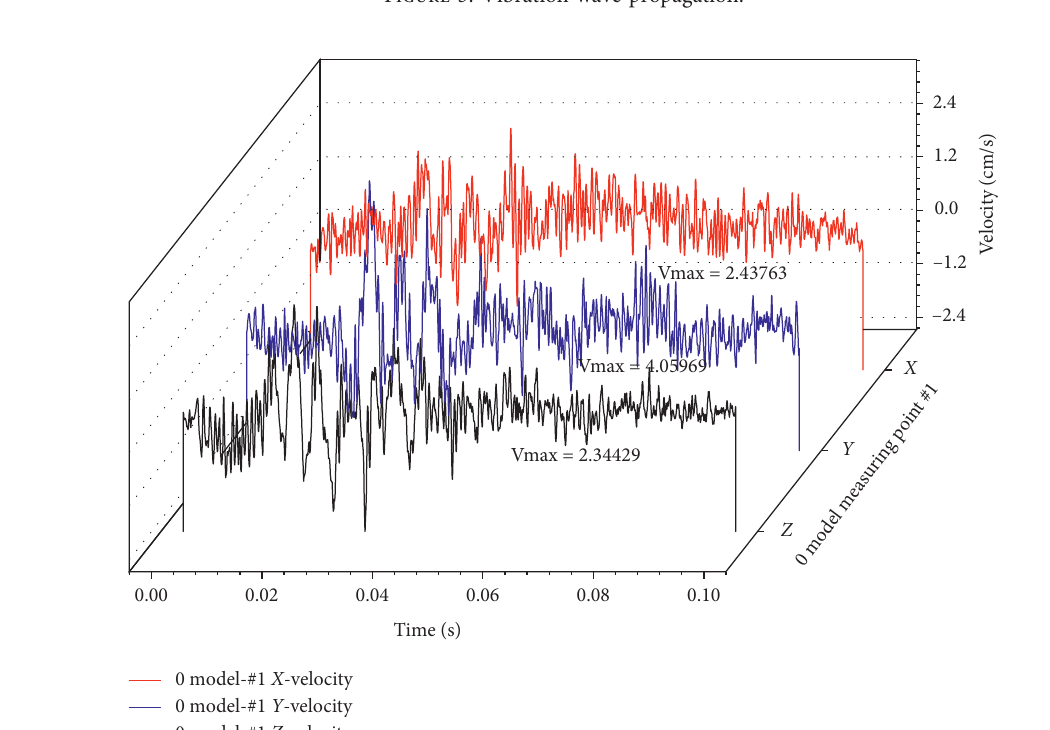
Figure 6: Vibration time history curves of the No. 0 model and #1